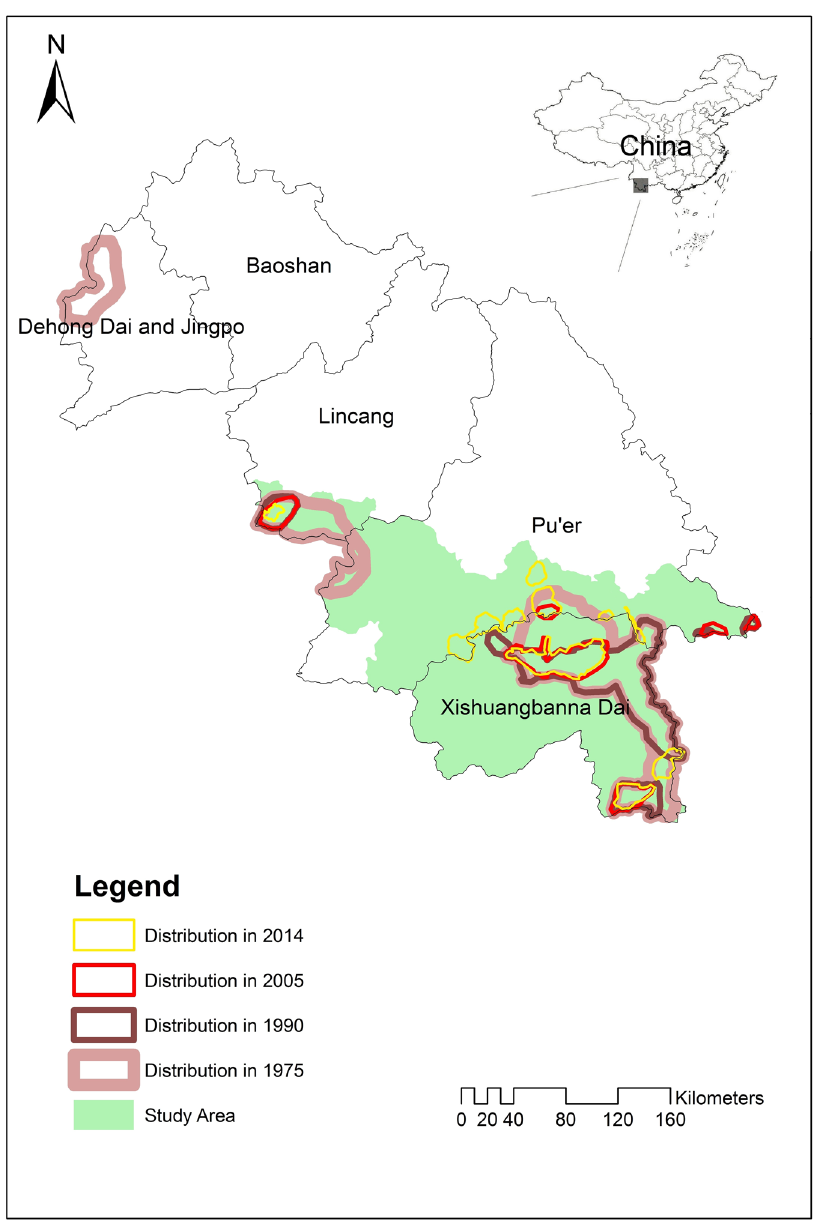
Figure 1. Distribtuion areas of Asian elephants in 1975, 1990, 2005 and 2014. ArcGIS 10.2 (ESRI Ltd., CA, USA. www.esri.com) were used to analyze the remote sensing images and GIS